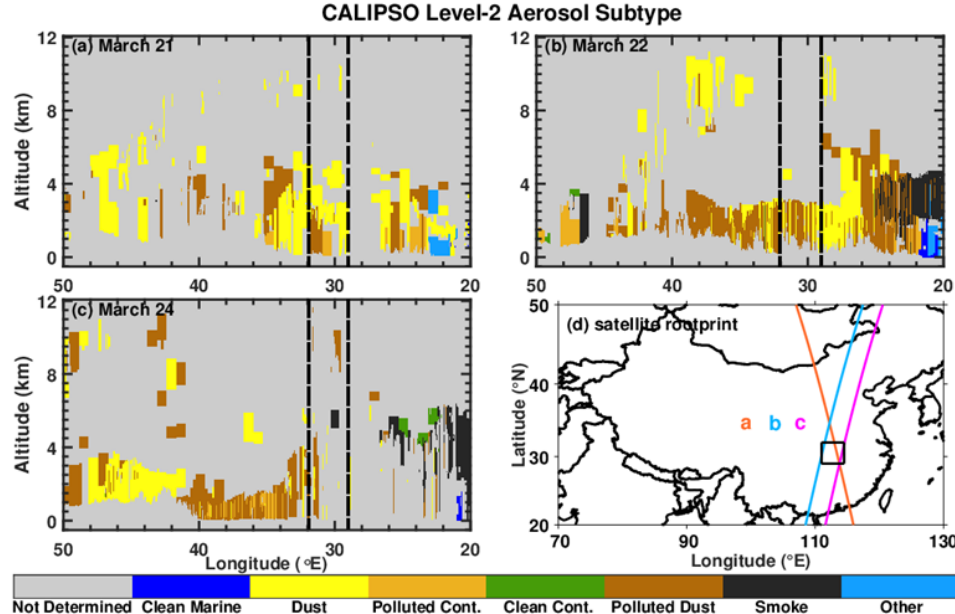
Figure 9. Vertical distributions of aerosol subtypes derived from the CALIOP level-2 aerosol product Vertical Feature Mask (VFM) on 21, 22, and 24 March 2018 ( a – c ). The corresponding satellite trajectories for ( a – c ) are presented in ( d ).